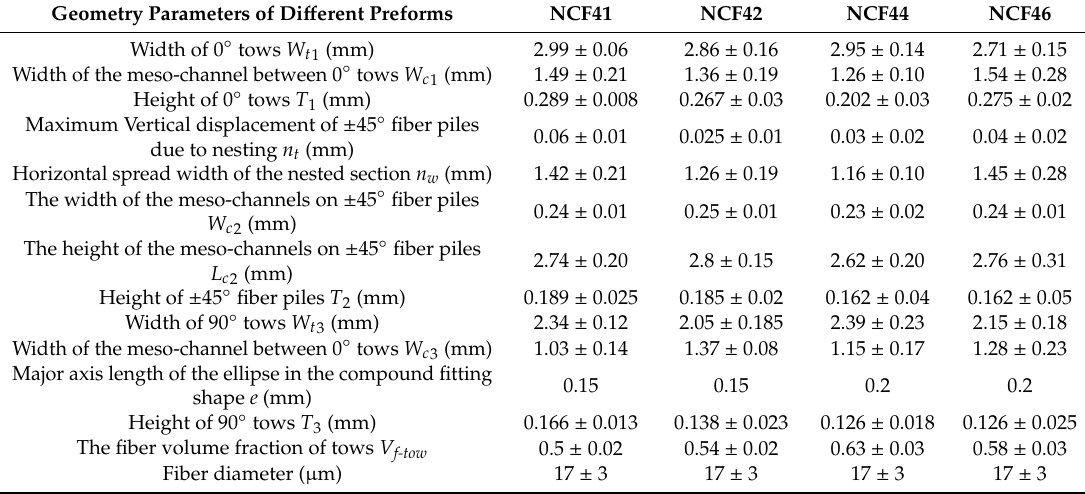
Table 5. Geometry parameters measured for the quadriaxial NCF preforms composed of multi layers.